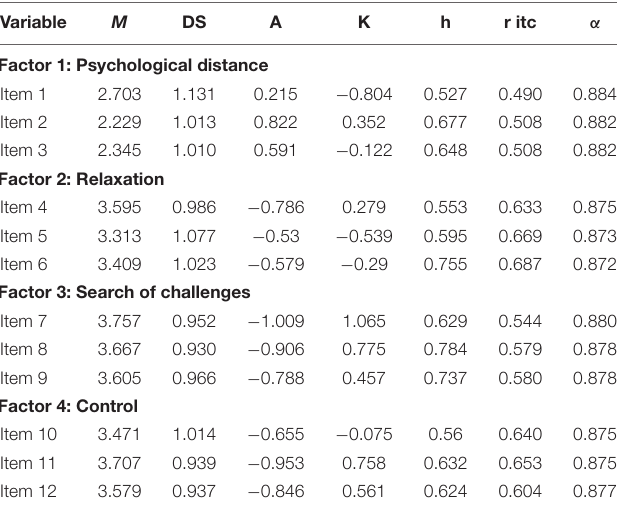
TABLE 1 | Preliminary analysis of the recovery experiences questionnaire